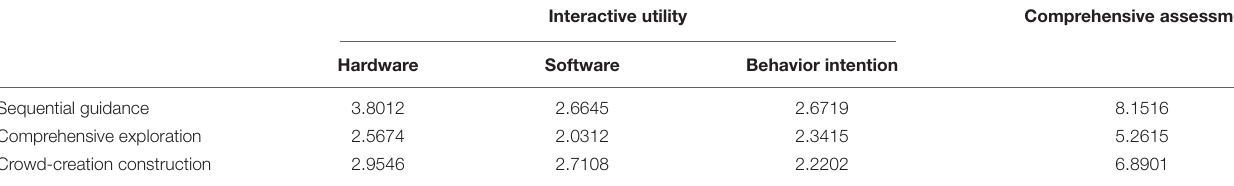
TABLE 1 | Interactive utility.